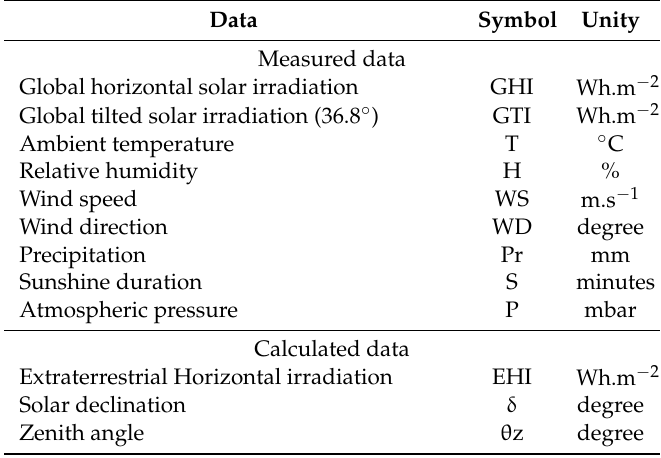
Table 1. Available meteorological data in